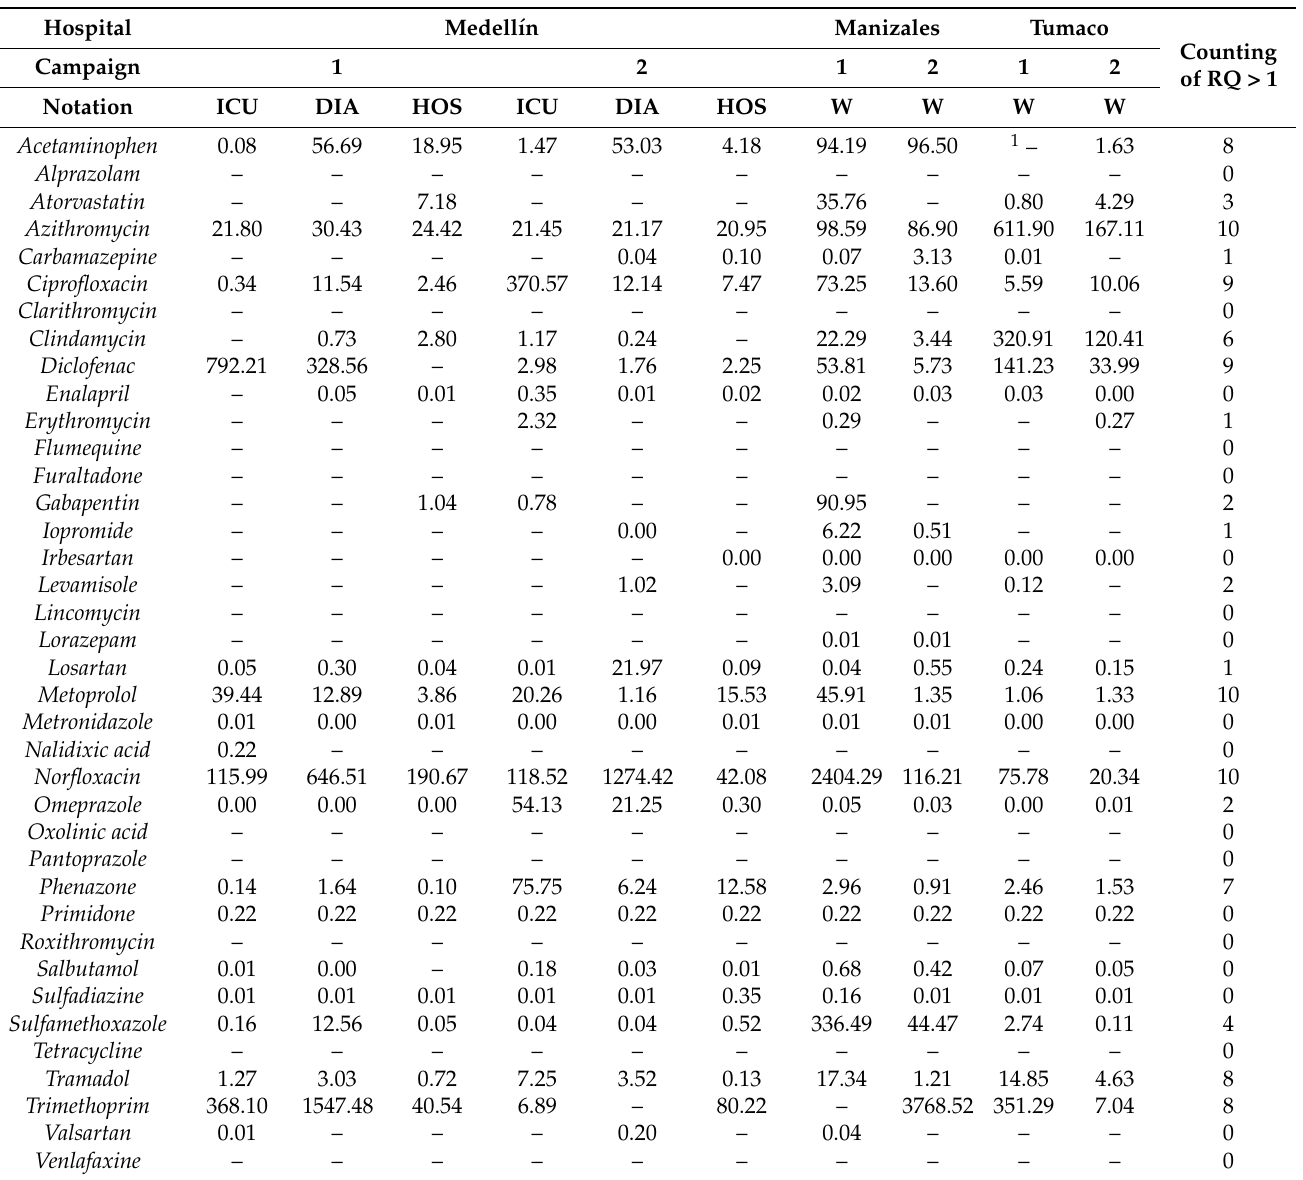
Table 3. Risk quotients (RQ m ) for the pharmaceuticals in the hospital wastewaters under Scenario a